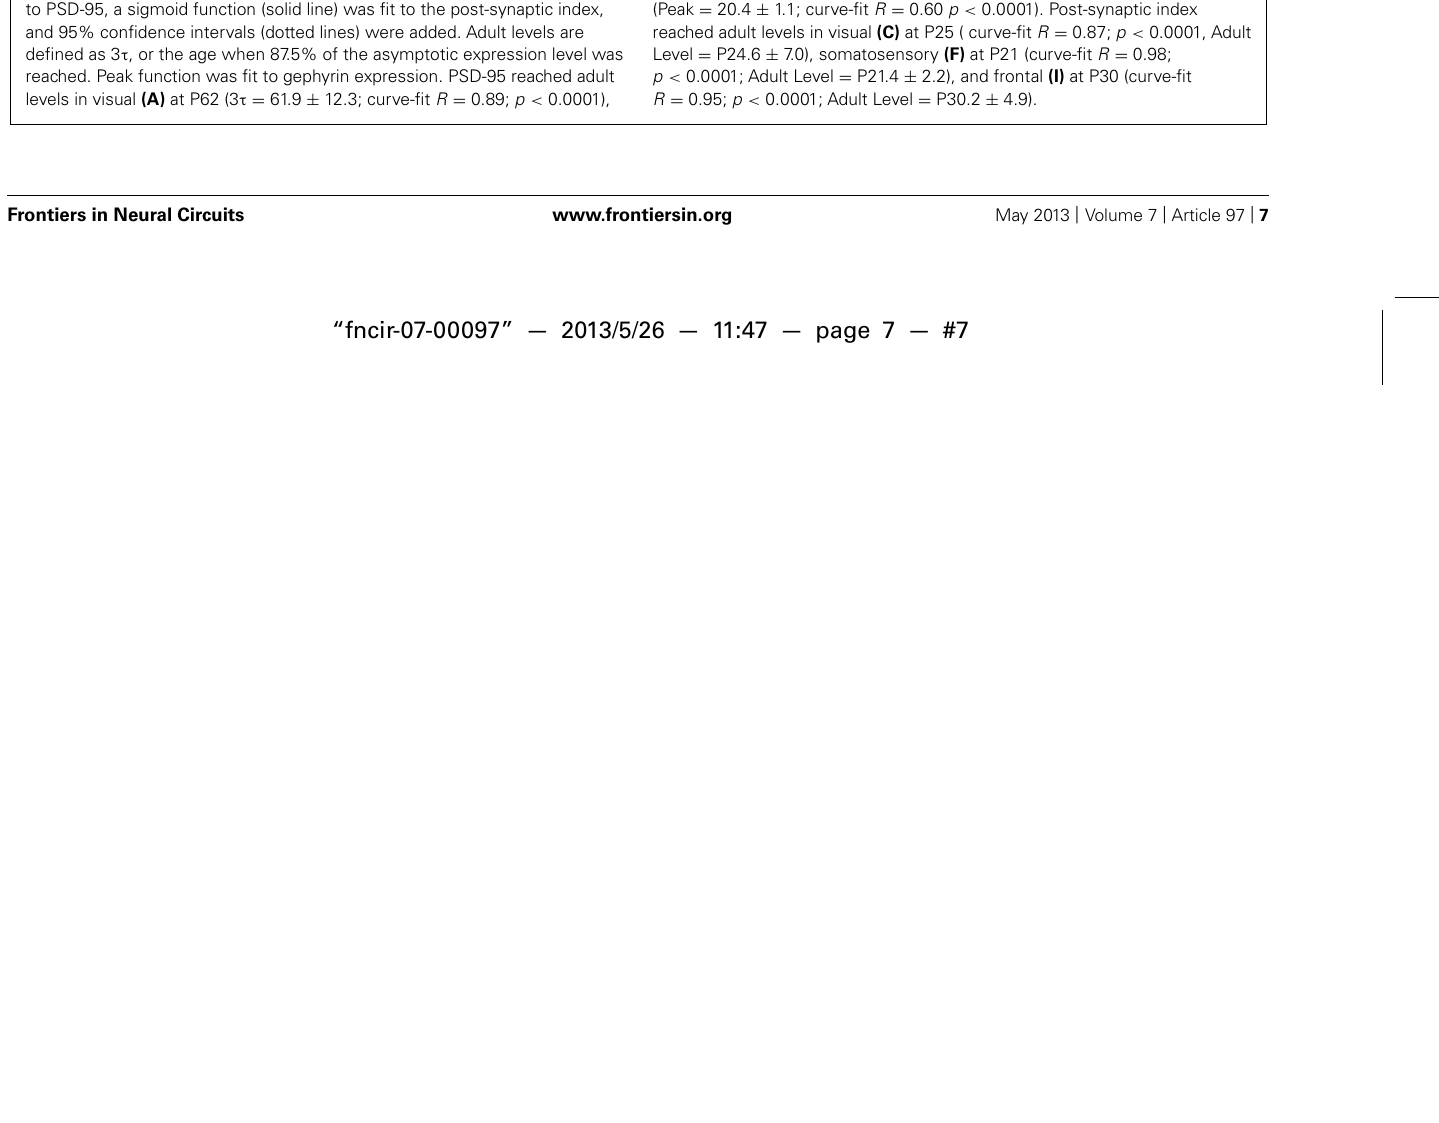
somatosensory (D) at P61 (3 τ = P61.221.4; curve-fit R = 0.82; p < 0.0001), and frontal (G) at P49 (3 τ = P49.1 ± 11.8; curve-fit R = 0.83; p < 0.0001). Gephyrin expression reached a peak in visual (B) at P29 (Peak = 29.3 ± 5.1; curve-fit R = 0.61 p < 0.0001), somatosensory (E) at P13 (Peak = 12.8 ± 5.1; curve-fit R = 0.48 p < 0.005), and frontal (H) at P20 (Peak = 20.4 ± 1.1; curve-fit R = 0.60 p < 0.0001). Post-synaptic index reached adult levels in visual (C) at P25 ( curve-fit R = 0.87; p < 0.0001, Adult Level = P24.6 ± 7.0), somatosensory (F) at P21 (curve-fit R = 0.98; p < 0.0001; Adult Level = P21.4 ± 2.2), and frontal (I) at P30 (curve-fit R = 0.95; p < 0.0001; Adult Level = P30.2 ±